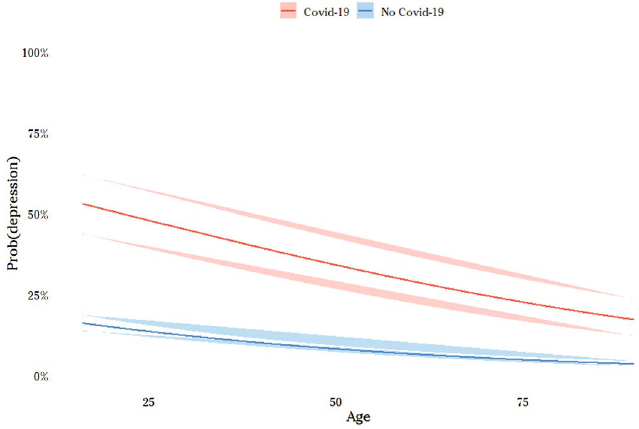
Figure 3. The effect of COVID-19 on the probability of depression (cut-off ≥ 12). (*) Note: effects calculated on the basis of the probit model of Table A.3 (age interval: 16–95). Confidence interval at 99%.